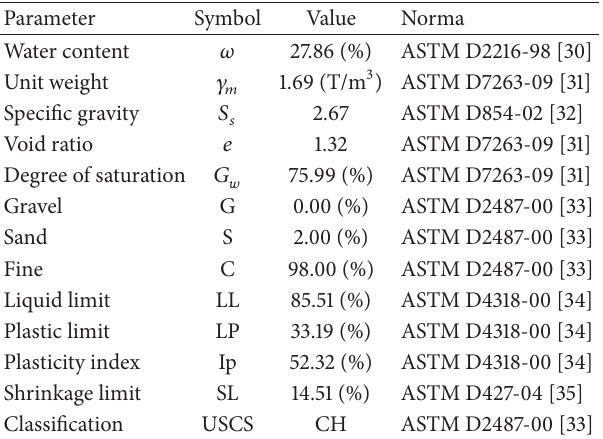
Table 2: Index properties of the expansive